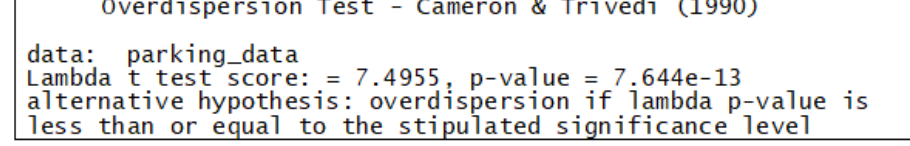
Figure 3. Result of the Cameron and Trivedi overdispersion test.